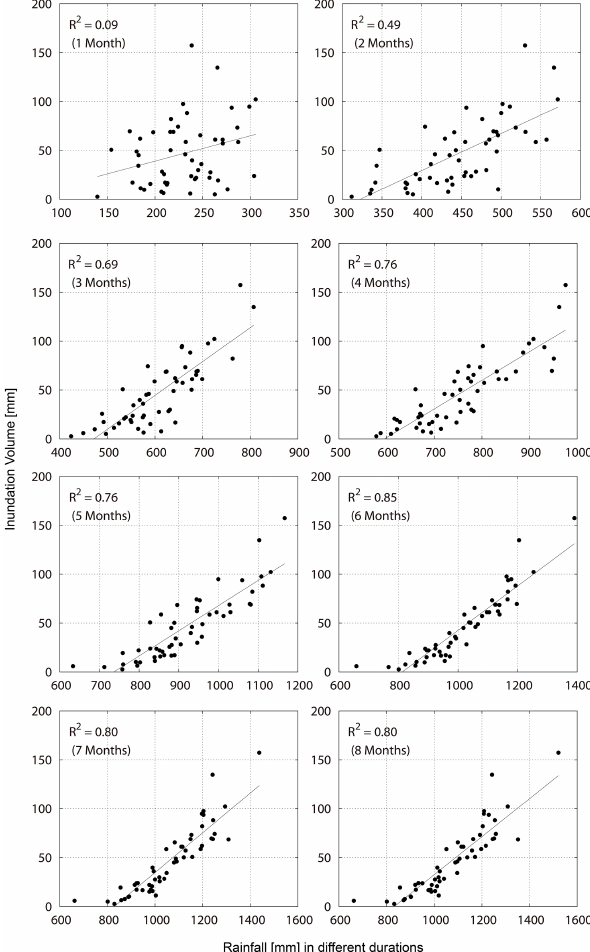
Figure 6. Relationships between annual maximum flood inunda- tion volumes ( y axis) and cumulative rainfall for different durations ( x